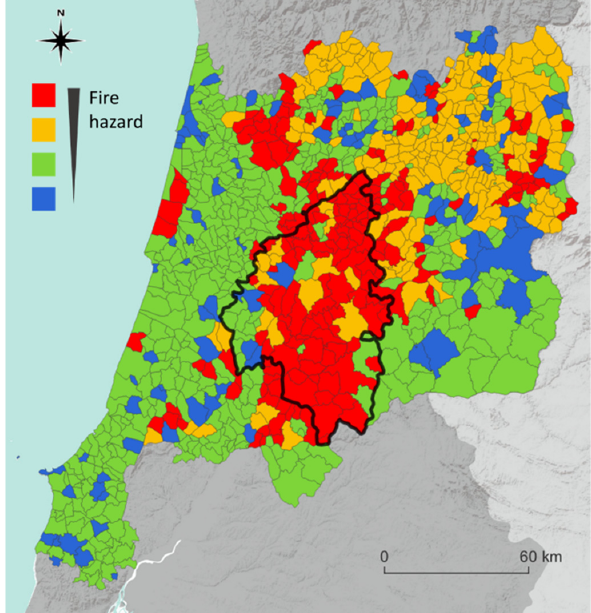
Figure 5. Classification of the parishes (small polygons) of Centro region and Pinhal Interior (thick black line delimited polygon) according to the four fire regimes derived from the TBA and GCI variables (see Figure 2).